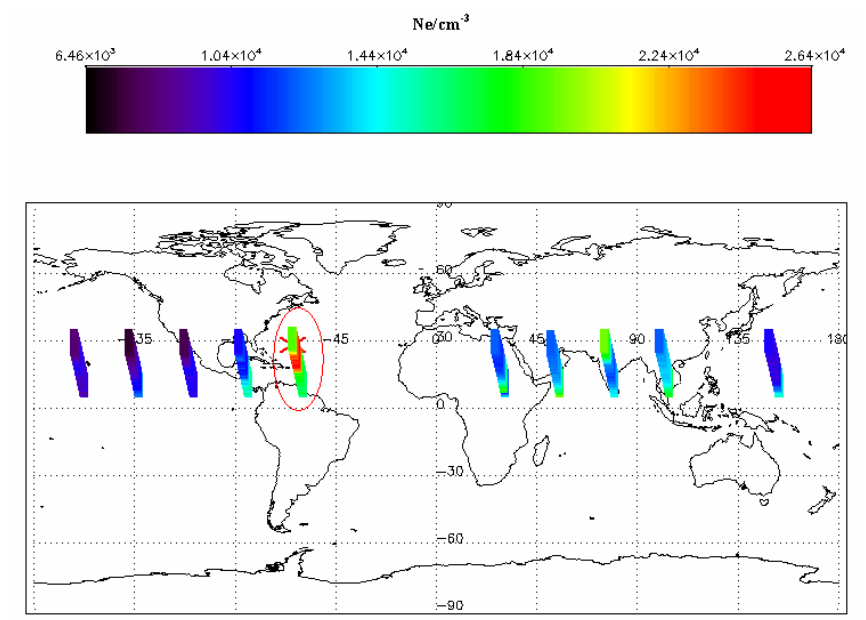
Fig. 5. Electron density distribution around the globe during nighttime on 11 January 2010. Star shows the epicenter of the Haiti